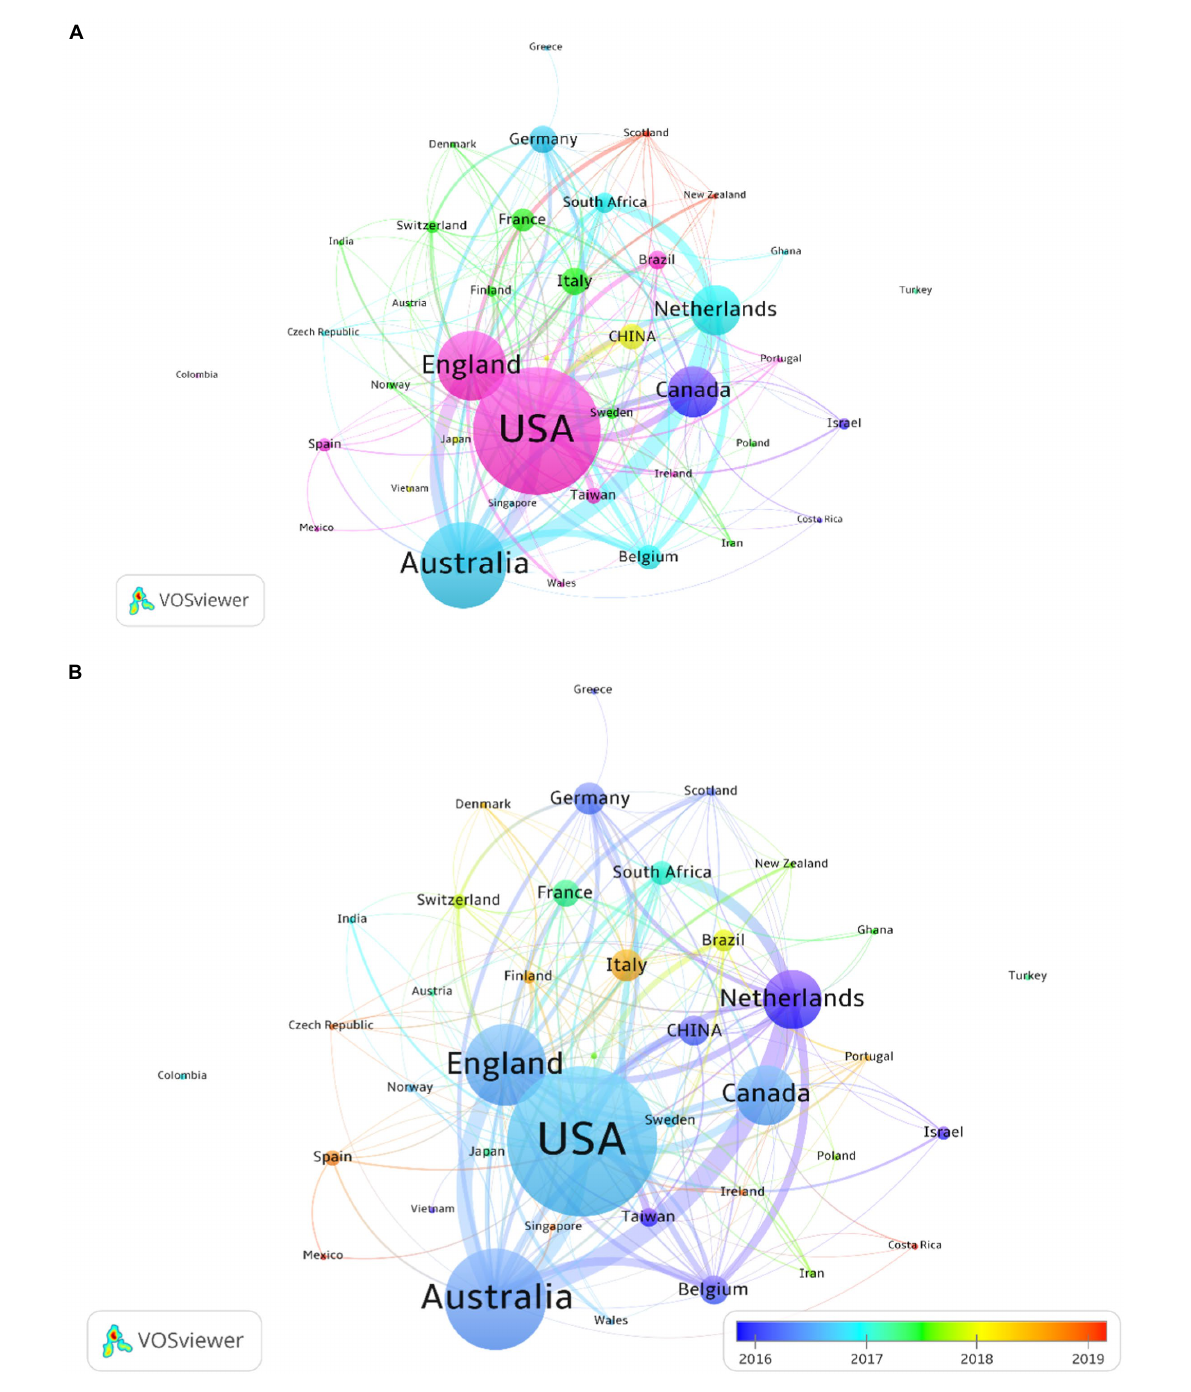
FIGURE 3 (A) Cooperation network visualization map of countries and regions based on VOSviewer; (B) Average annual publication year map of countries and regions based on